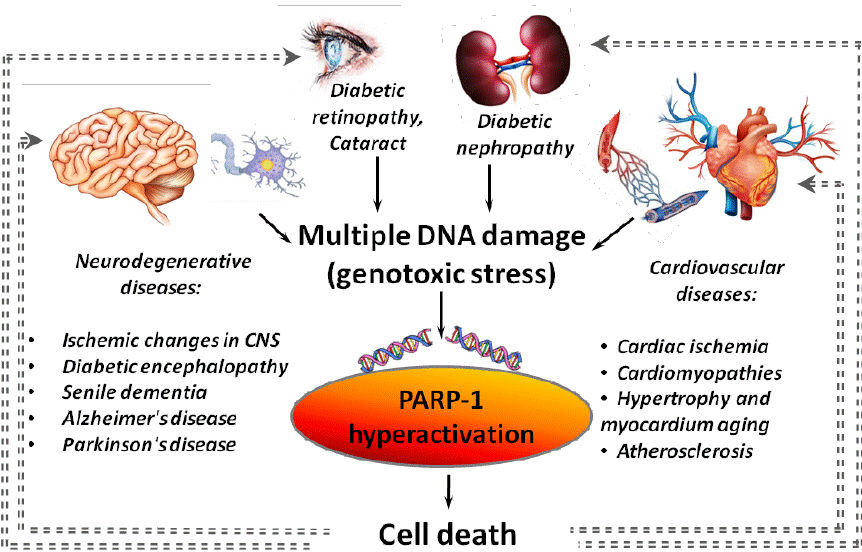
Figure 1. PARP-1 hyperactivation as an aggravating factor in the development of various diseases. Gray dotted lines indicate “vicious circles” when PARP-1 hyperactivation initiated by inflammation, cardiovascular, neurodegenerative or diabetic pathology leads to an increase in the severity of the disease.